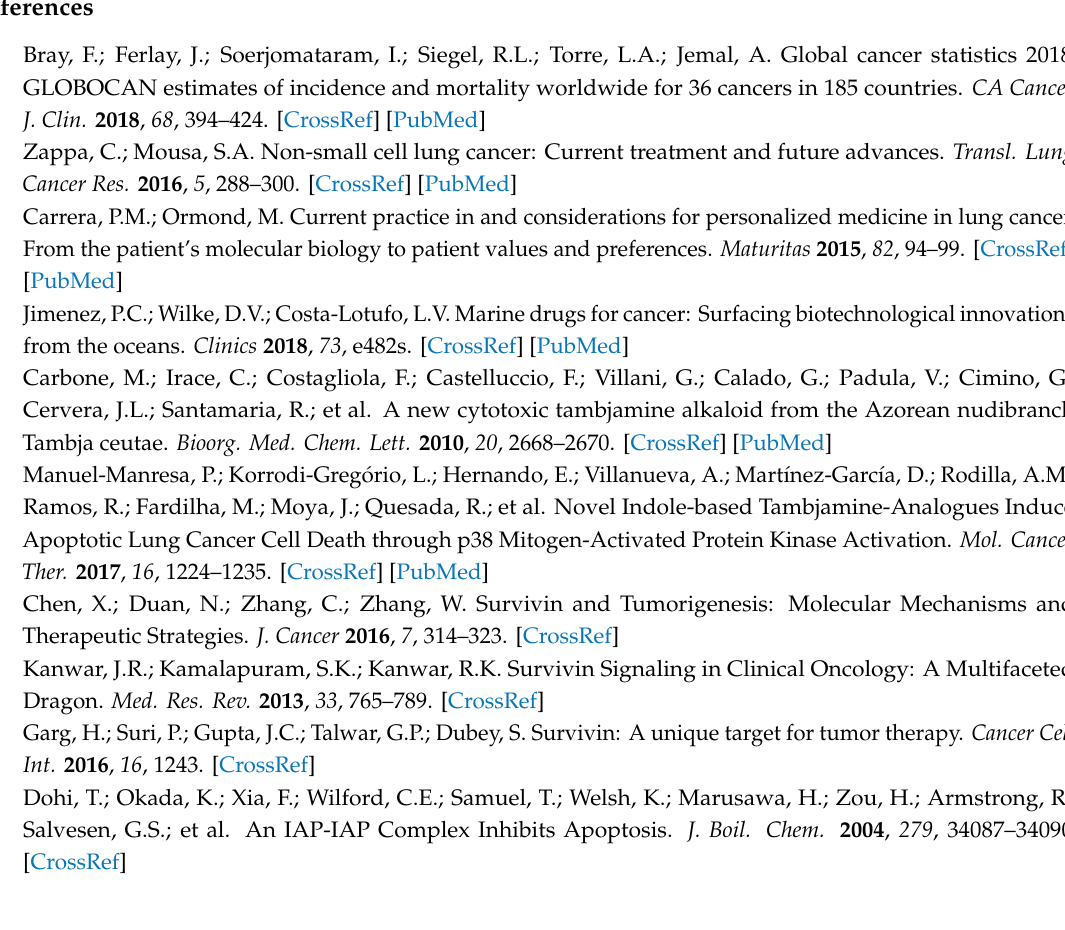
Figure S2: E ff ects of T21 on cell viability by a clonogenic assay. Figure S3: JAK2 activity after T21